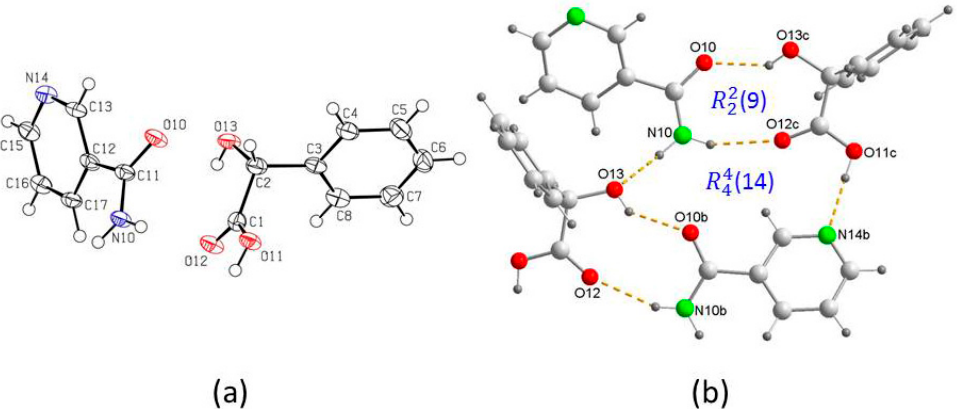
Figure 2. ( a ) Asymmetric unit of nam - D-H 2 ma and ( b ) four-membered supramolecular unit in the crystal structure of the nam - D-H 2 ma (1:1) crystal structure of the nam - D-H 2 ma (1:1) co-crystal.